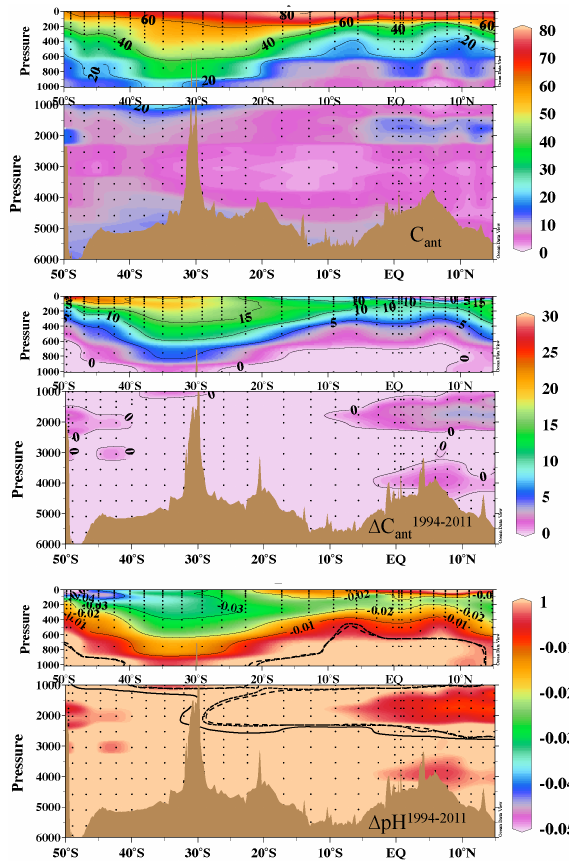
Figure 4. Distribution of C ant (µmolkg − 1 ) calculated using the φ C 0 method with the GEOTRACES-NL (2010/2011) data set T (top); distribution of (cid:49) C 1994 − 2011 ant (µmolkg − 1 ) , calculated us- ing the eMLR approach (middle); and the distribution of the (cid:49) pH 1994 − 2011 associated with (cid:49) C 1994 − 2011 ant (bottom). The arag- onite saturation horizon ( (cid:127) Ar) is marked for pre-industrial times (solid line), 1994 (dashed line) and 2011 (dotted